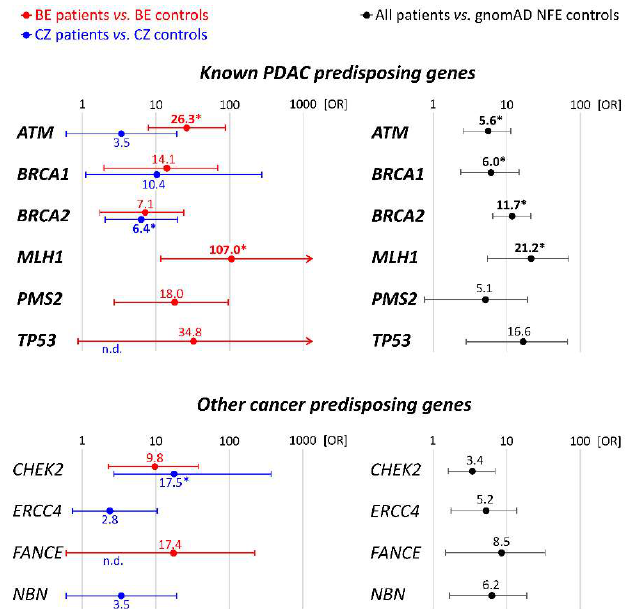
Figure 1. Gene specific PDAC risks in Belgian and Czech PDAC patients (compared with population-matched controls) and all PDAC patients (compared with gnomAD NFE). The plots showing OR and 95%CI describe only genes associated significantly with PDAC Belgian, Czech, or all PDAC patients, respectively. All genes are presented in detail in Table S5. OR values in bold denoted by an asterisk (*) remained significant following Bonferroni correction for multiple testing. n.d.—not determined (zero carriers in population-matched controls).